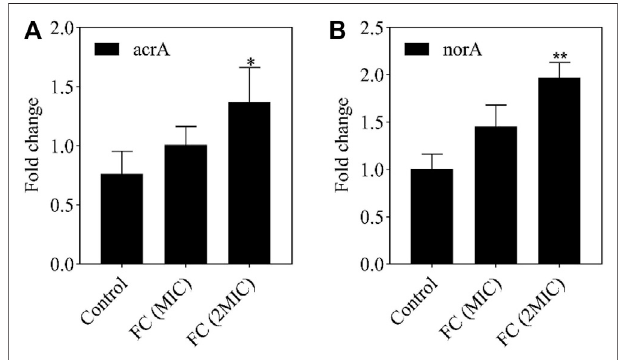
FIGURE 6 | The effect of MIC and 2MIC concentration FC on gene expression levels. Thefold change in theexpression level ofacrA (A) , norA (B) inthe E.coli , S.aureus ofdifferentconcentration(MIC,2MIC)ofFCgroupwere compared to the control without FC treatment by using RT-PCR. Data from the RT-PCR analysis is represented as mean ± SEM. By t -test analysis, * p < 0.05, ** p < 0.01 comparing to the control